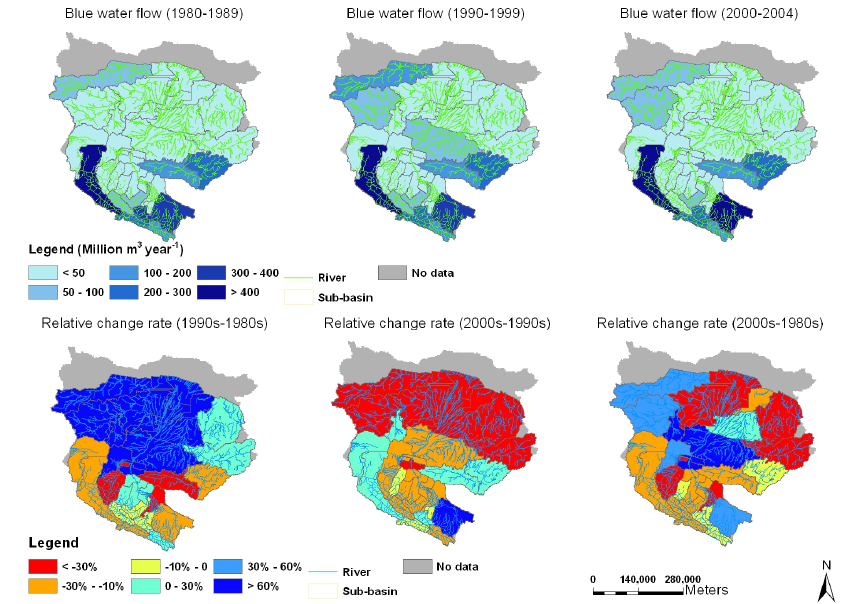
Fig. 6. The blue water flows (the best simulation and long term average annual values) (million m 3 yr − 1 ) from the 1980s to the 2000s in the Heihe river